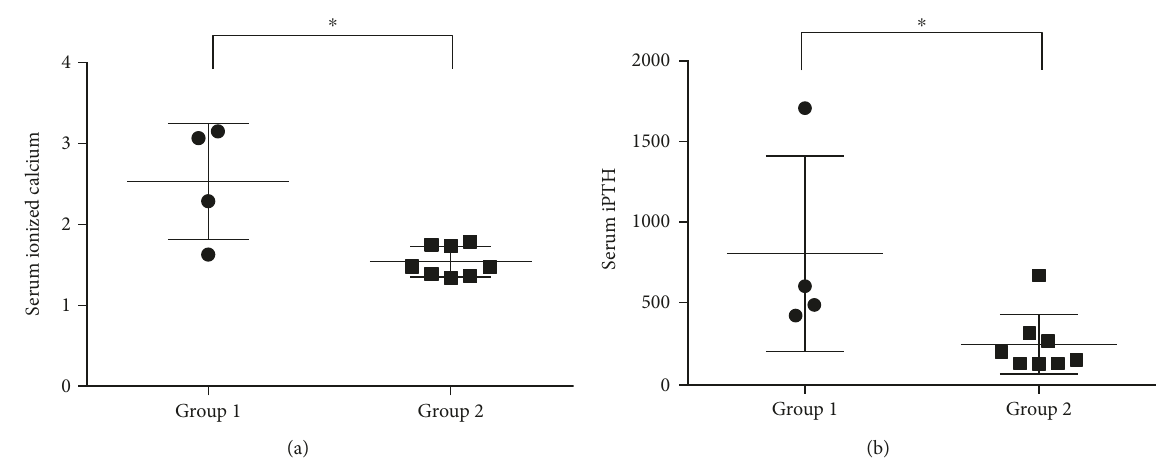
Figure 1: Comparisons of the preoperative serum level of ionized calcium and iPTH between patients with pHPT during pregnancy with severe complications (group 1) and those with mild hyperparathyroidism or who were diagnosed postpartum (group 2). (a) The serum level of ionized calcium was signi fi cantly higher in group 1 than in group 2 (Mann – Whitney U test, p = 0 0283 , ∗ p < 0 05 ). (b) The serum level of iPTH was signi fi cantly higher in group 1 than in group 2 (Mann – Whitney U test, p = 0 0263 , ∗ p < 0 05 ). Table 2: Comparisons of clinical information between patients with pHPT during pregnancy with severe complications (group 1) and patients with mild hyperparathyroidism or those with a postpartum diagnosis (group 2). Group 1 Group 2 p value Maternal age (years) 30.8 ± 6.0 29.3 ± 3.5 0.4343 3.2 ± 1.2 2.1 ± 0.7 0.1051